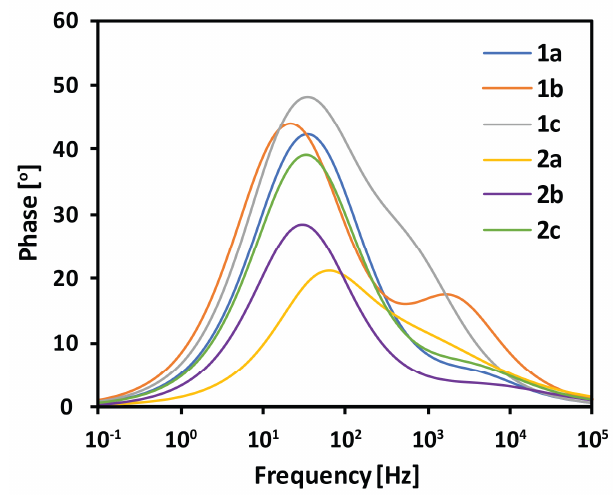
Figure 8. Bode phase plot under V OC forward bias conditions.